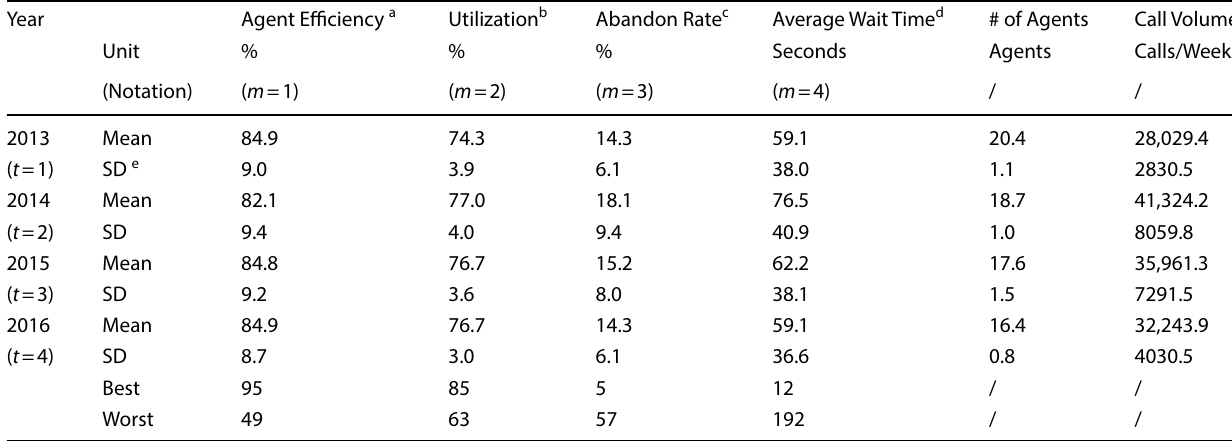
Table 1 City of Chicago 311 contact center data (2013—2016)—a